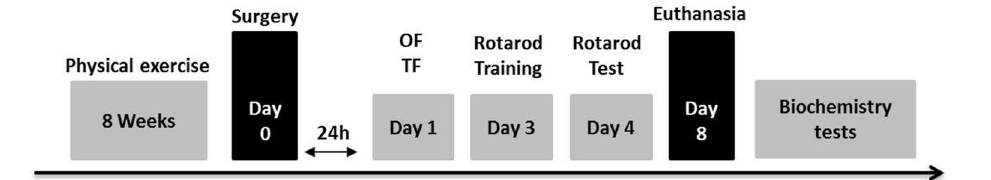
Figure 1. Rats in the exercise (EXERC) and exercise and ischemia-reperfusion groups (EXERC-ISCH) were subjected to 8 weeks of physical exercise on a treadmill for rodents. On day 0, rats from all groups underwent surgery with or without occlusion of the carotid arteries. Twenty-four hours after surgery rats were given open- fi eld (OF) and tail- fl ick tests (TF). On the third day, rats were trained in the rotarod test and on the fourth day they were given the rotarod test. To avoid changes in brain markers resulting from stress due to the rotarod test, rats were euthanized and brain tissue was collected a few days later, on the eighth day post-surgery. Bilateral striatum tissue was removed and used in subsequent biochemical assays.